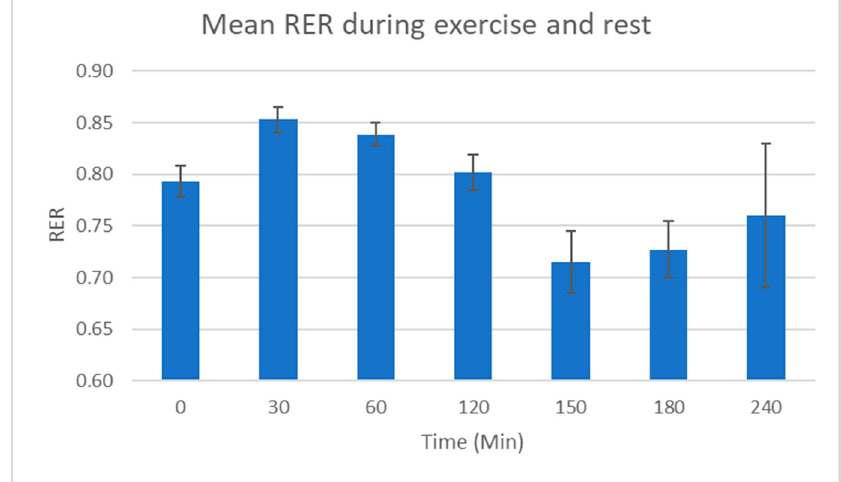
Figure 3. Average respiratory exchange ratio (RER) for all participants. Data suggests mainly glycolytic energy metabolism during the exercise phase of the protocol, then, an increase in fatty acid energy metabolism during rest with a trend back towards glycolytic metabolism at the end of the protocol.